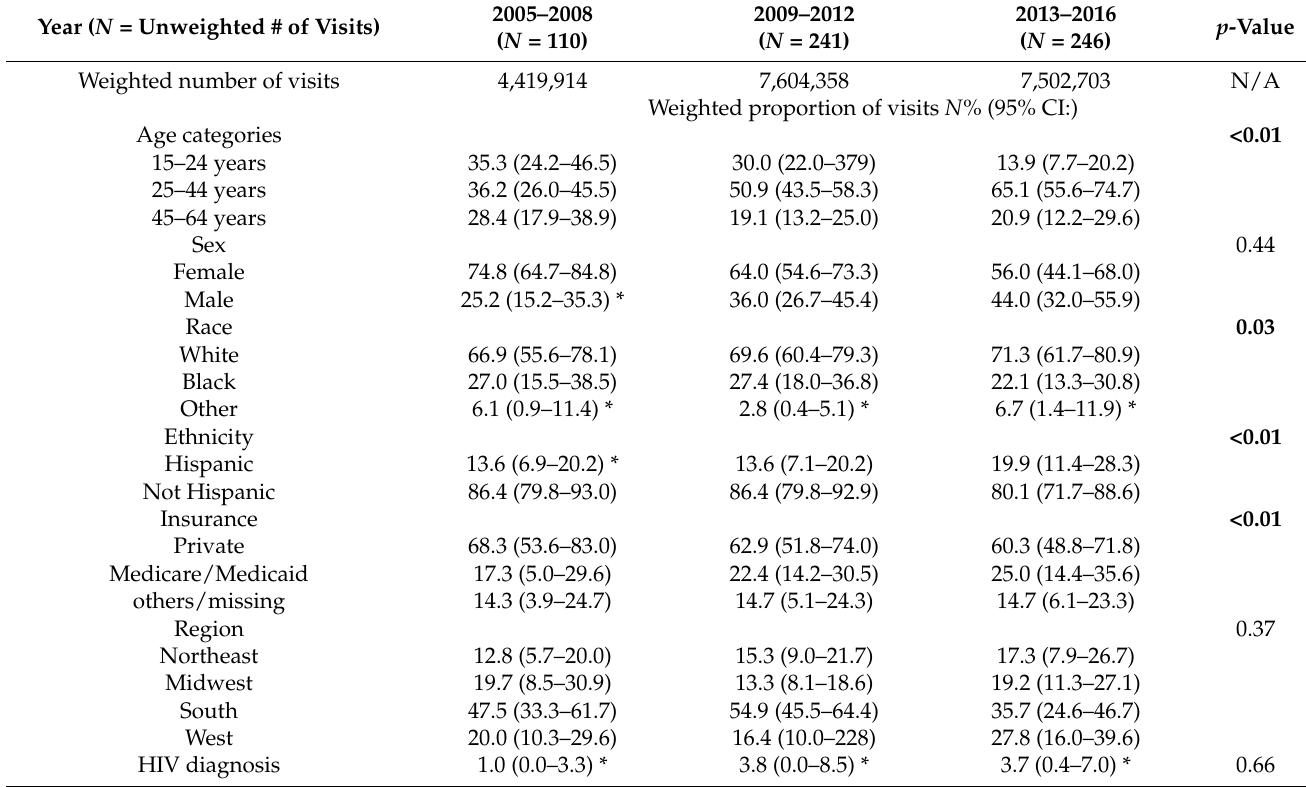
Table 2. Demographic differences in STI by each time period using data from NAMCS.